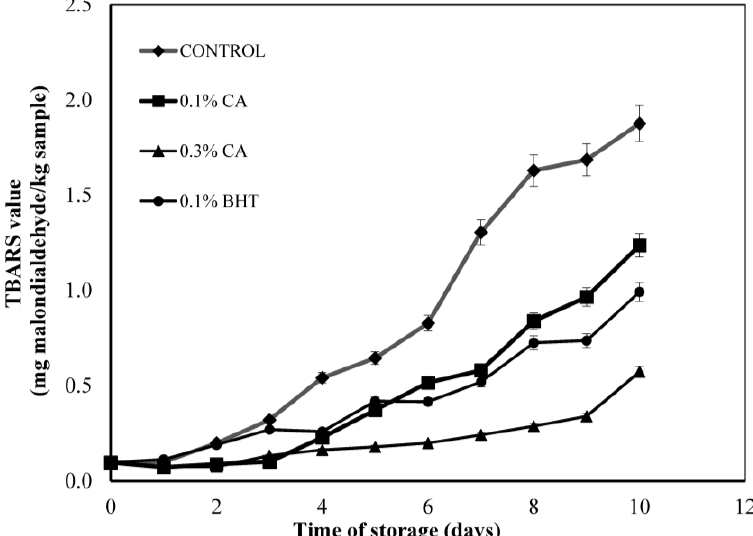
Figure 2. Changes in TBARS values (mg malondialdehyde/kg sample) of control and sample containing different concentrations (0.1% and 0.3% w/w) of CA extract in MAP atmosphere during 10 days storage at 4 ± 1 °C without light. Each sample was measured in triplicate and the average standard deviation for each sample was less than